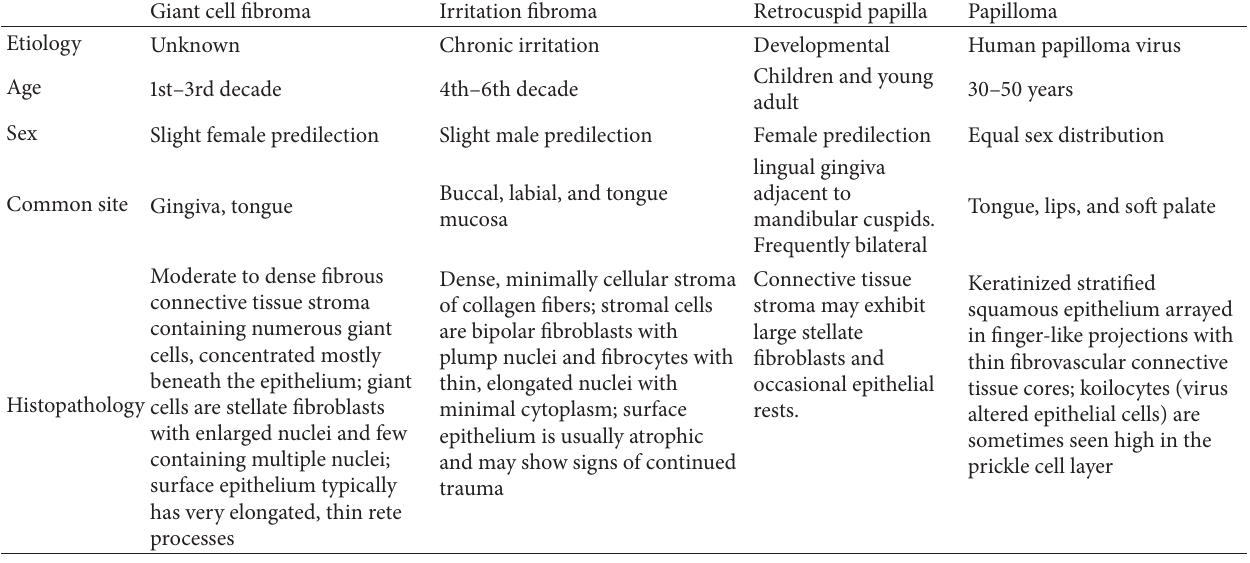
Table 1: Illustrating comparison between giant cell fibroma, irritation fibroma, retrocuspid papilla, and papilloma.